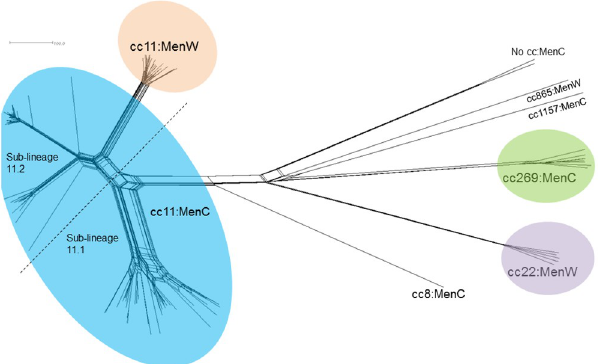
Fig 3. cgMLST NeighbourNet diagram showing the population structure of MenC and MenW disease isolates from the RoI (n = 135). The majority of isolates, 86% (n = 116/135) were cc11; 90 MenC (74 invasive and 16 from carriage) and 26 MenW isolates (14 invasive and 12 from carriage). The remaining 19 isolates were identified as members of cc269 (n = 8), cc22 isolates (n = 6), cc865 (n = 1) and cc1157 (n = 1) complexes, and two isolates were unassigned to a clonal complex. The scale bar represents a pairwise allelic difference of 100.